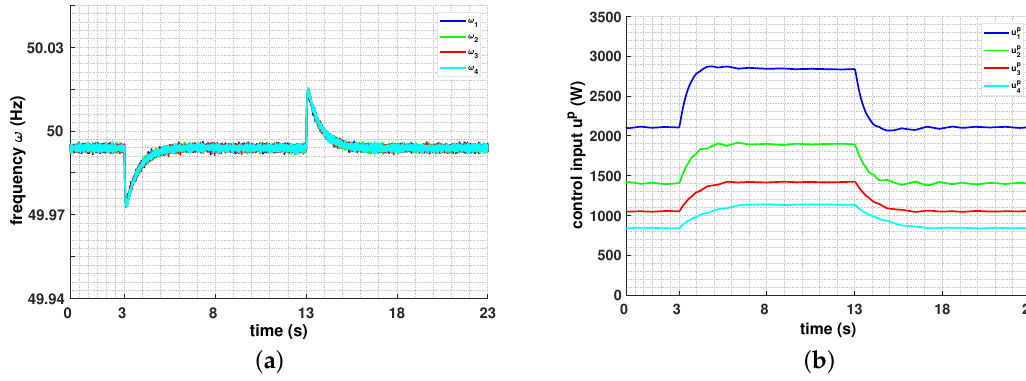
Figure 5. Responses of frequency and active power control input for event-triggered mechanism